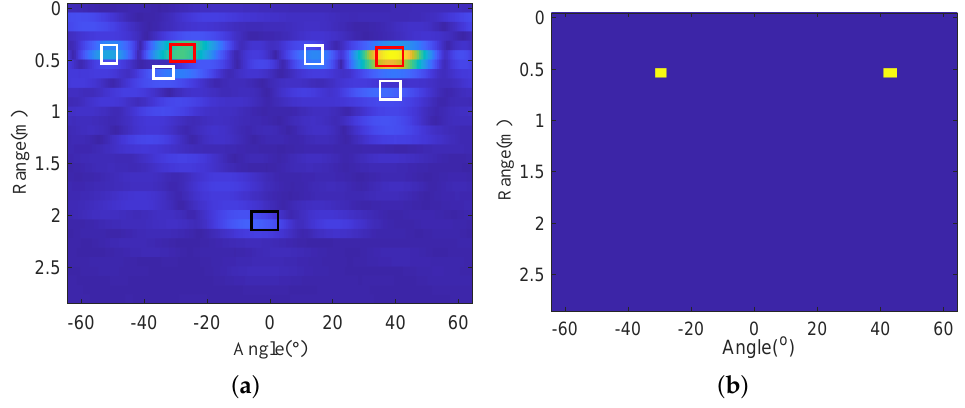
Figure 9. Effect of interference suppression for RAM. ( a ) Original. ( b ) After interference suppression.